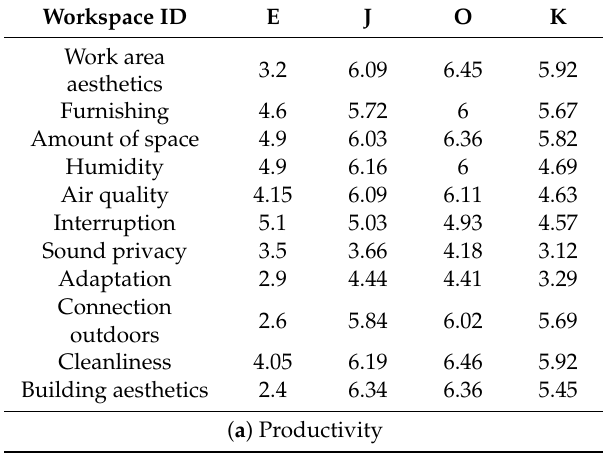
Table 7. Mean satisfaction scores for ( a ) perceived productivity, ( b ) health, and ( c ) overall comfort of work